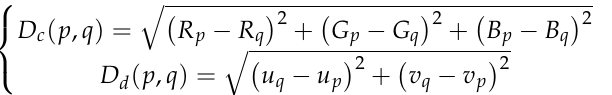
According to the method, the weight distribution rules of each pixel in the support window can be obtained, as shown in Equation (25).